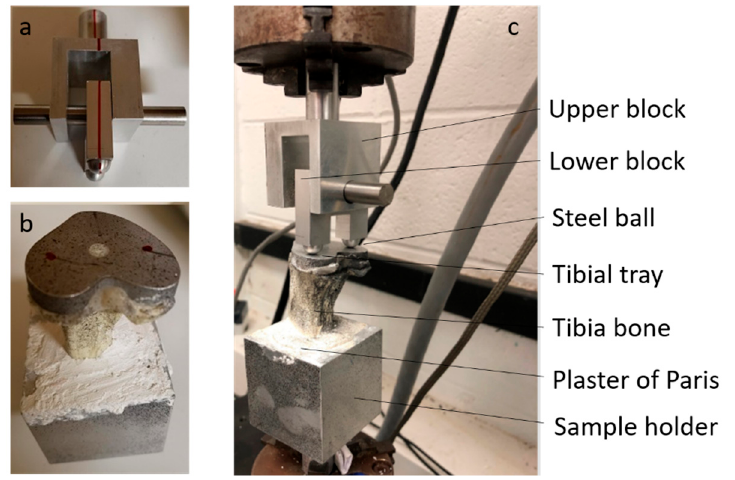
Figure 5. Preparation of cemented TT samples in UTM: ( a ) mechanism attached with UTM top gripper. The red line shows alignment of balls with the upper block center axis, ( b ) cemented TT samples. Red dots indicate indentation positions, ( c ) mechanical tests on a cemented TT sample.